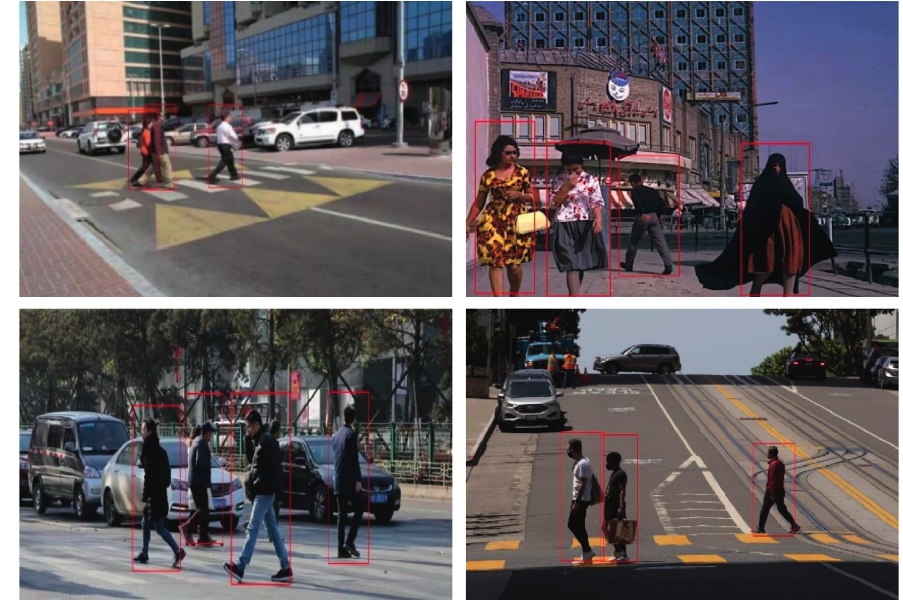
Figure 2: Pedestrian detection